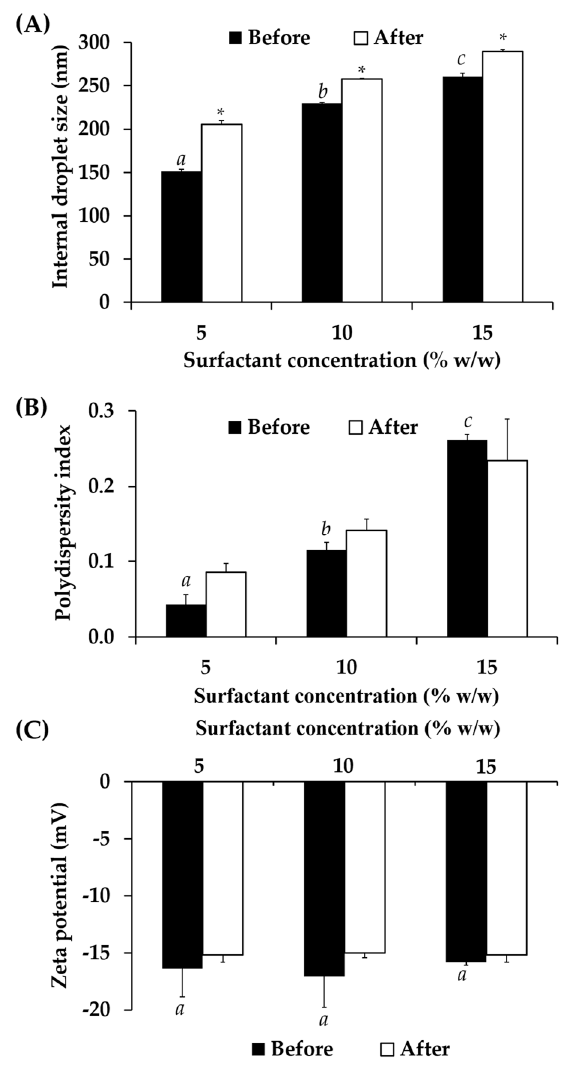
Figure 12. The internal droplet size ( A ), polydispersity index (PDI) ( B ), and zeta potential ( C ) of nanoemulsion containing C. militaris extract, before and after 8 cycles of heating-cooling condition. The letters a, b, and c denoted significant difference between formulations analyzed using post-hock Tukey ANOVA ( p < 0.05). Asterisk (*) denoted significant difference between before and after the stability test analyzed using t-test ( p < 0.05).